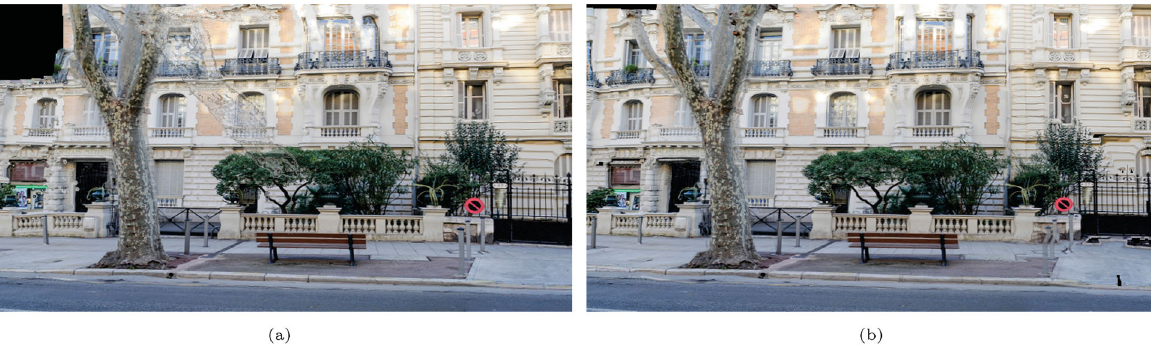
Fig. 9 Comparison between (a) image interpolated using the baseline method with a constant label set, (b) generated by our method with label set